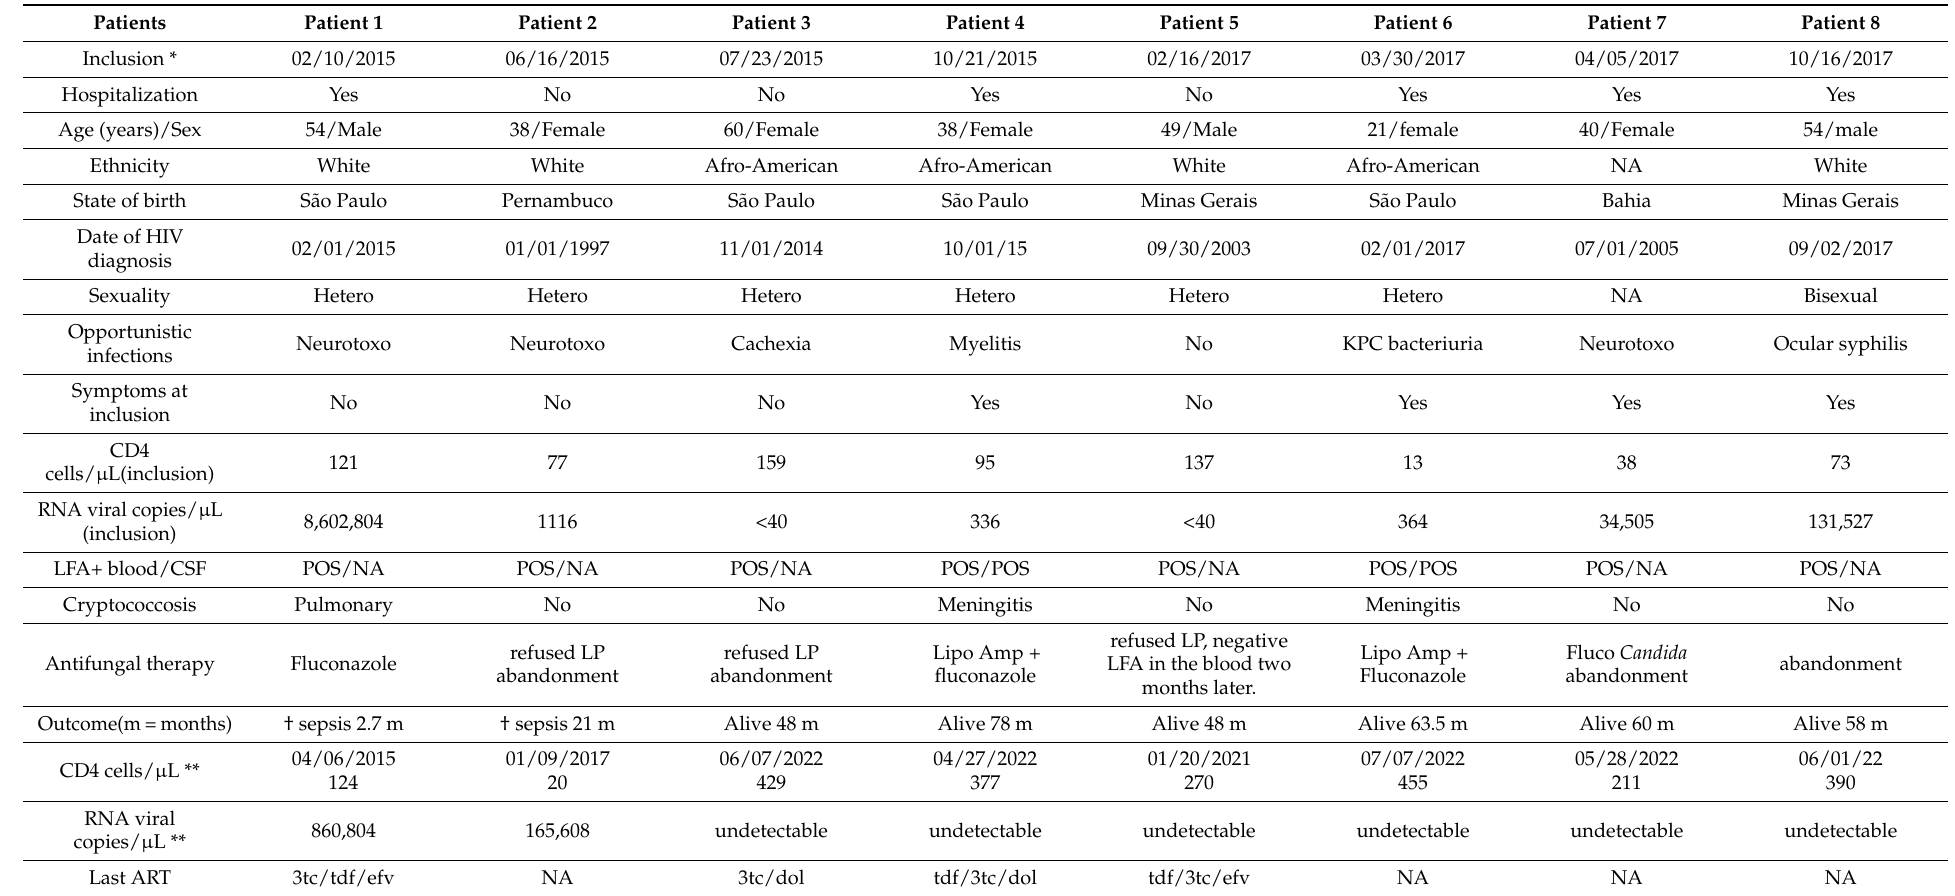
Table 3. Characteristics of the eight positive LFA patients, pre-emptive antifungal therapy, antiretroviral treatment, and